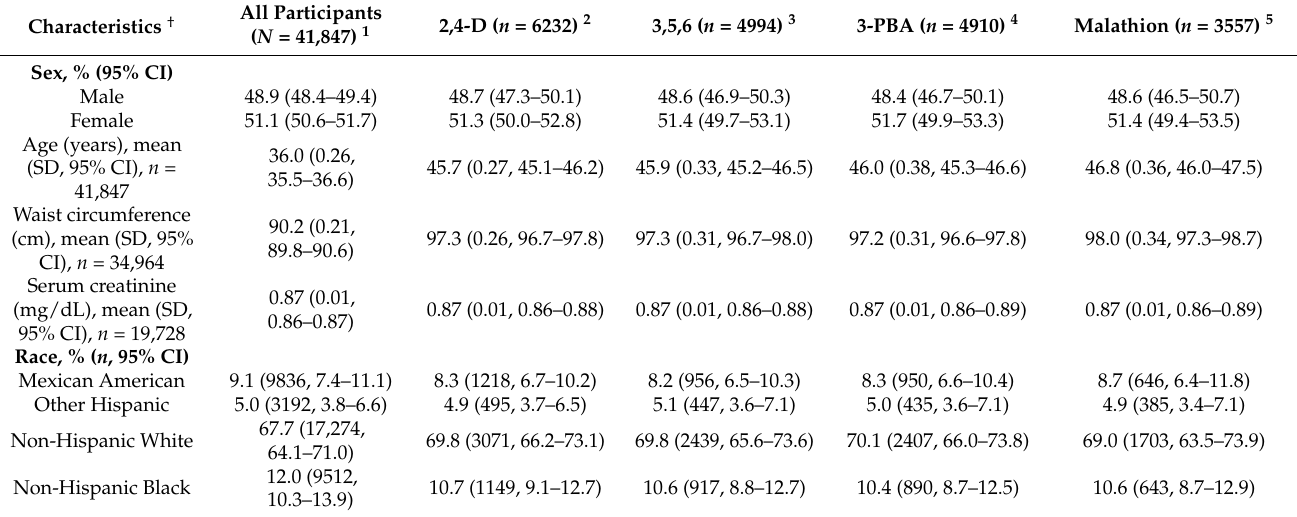
Table 1. Demographic characteristics of participants in the National Health and Nutrition Examination Survey conducted in the US between 2001–2004 and